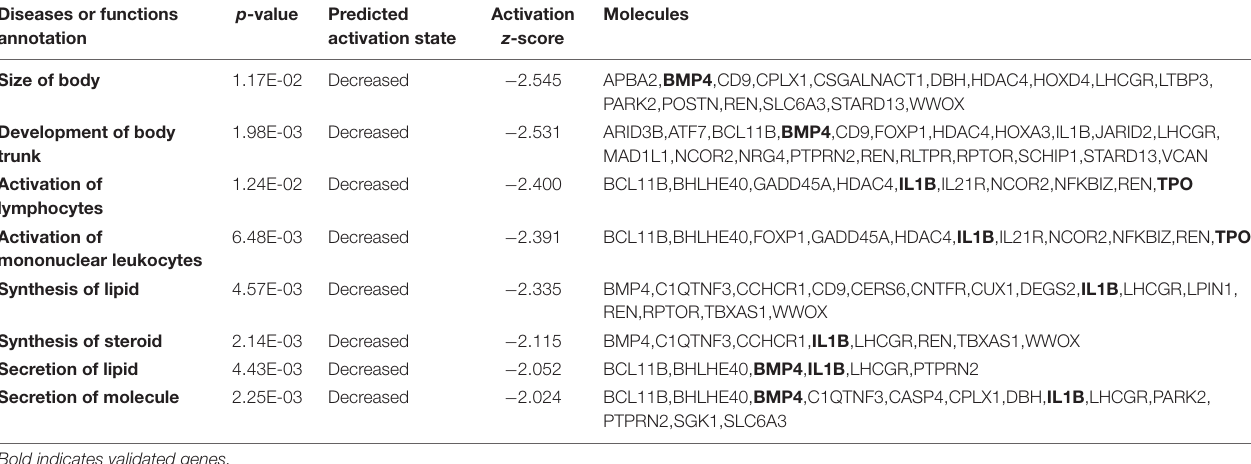
TABLE 2 | Eight disease/functional annotations according to the IPA database.